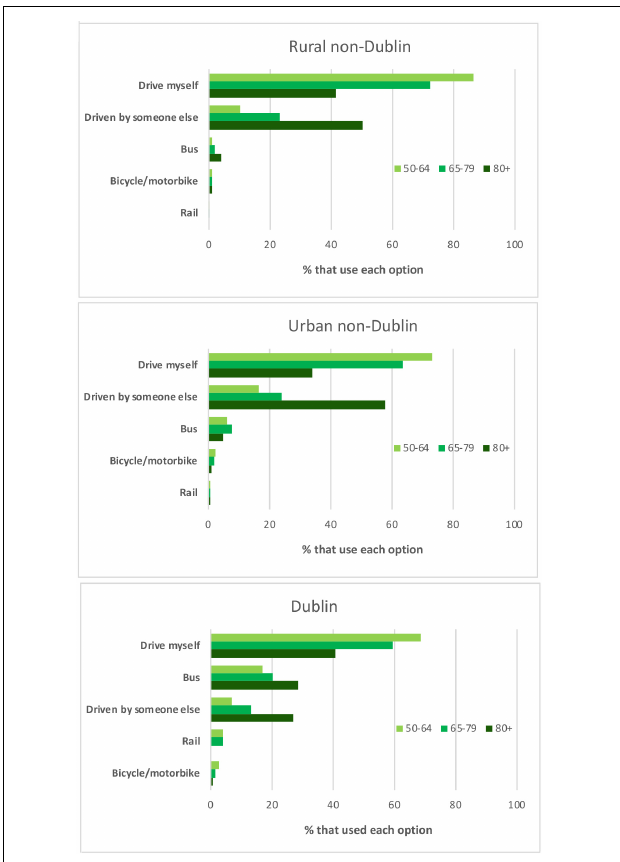
FIGURE 1 | Modes of transport most commonly used across Location and Age 2 .